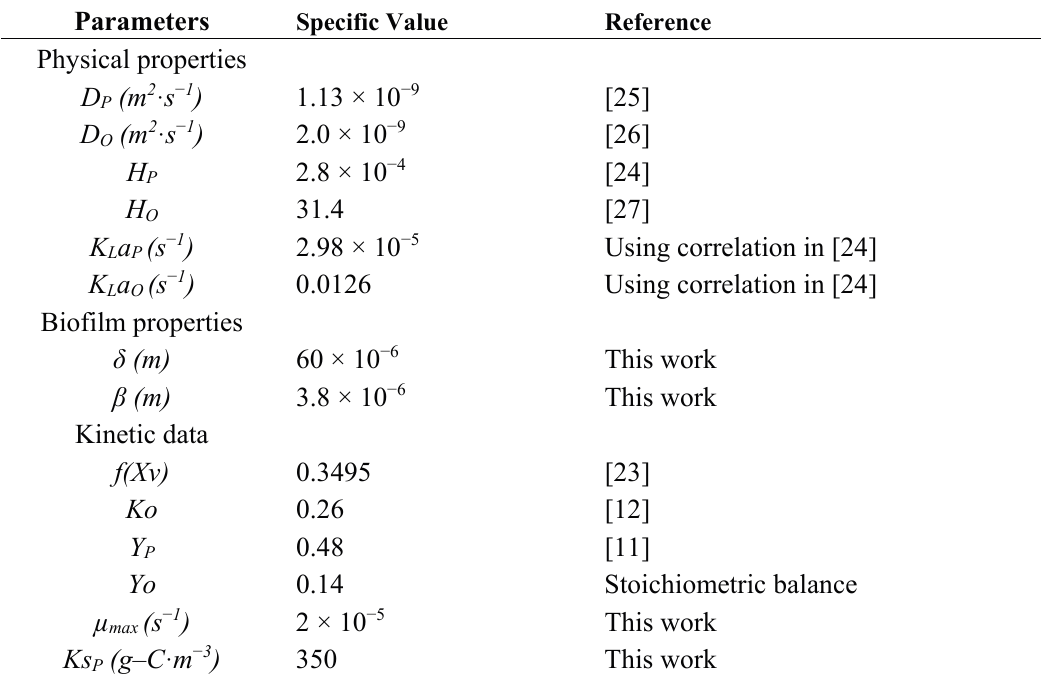
Table 3. Parameters used in the modelling of BTF at the laboratory